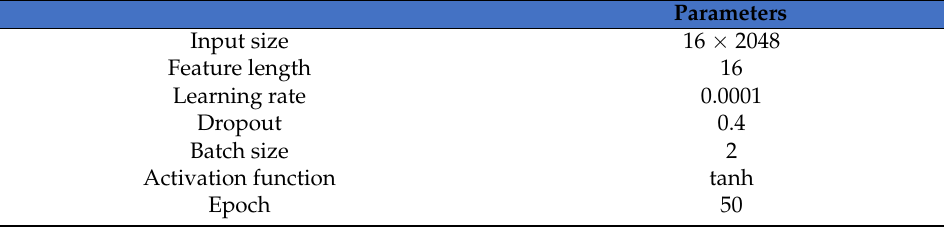
Table 10. Training parameters of LSTM model.